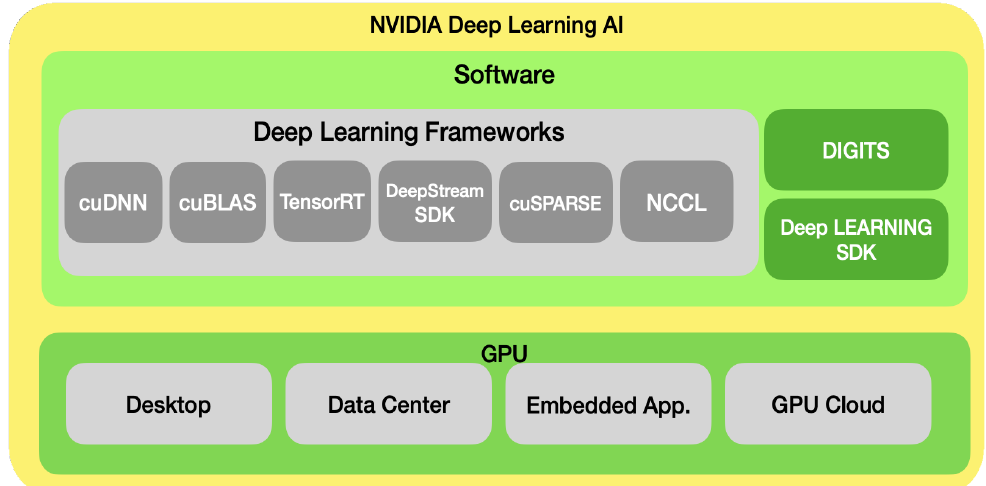
Figure 13. AMD Deep Learning [49].